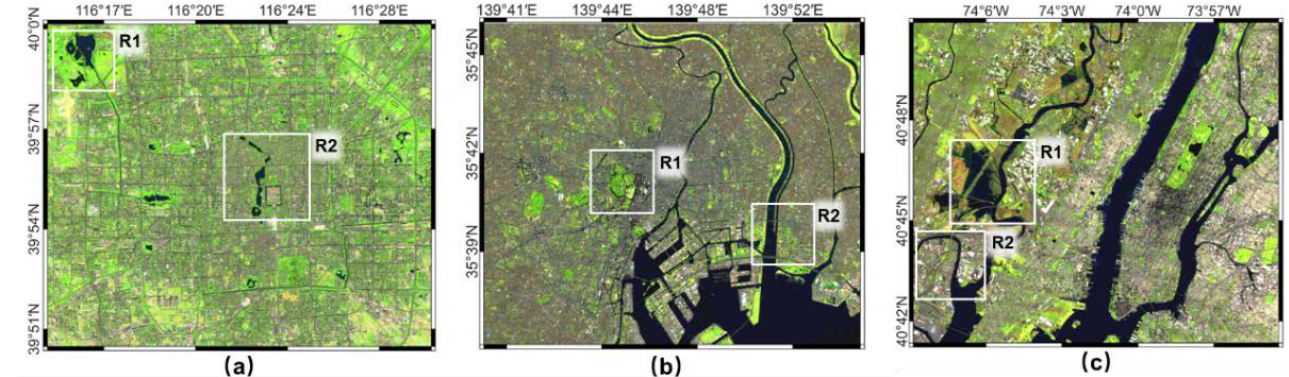
Figure 5. Selected subregions (R1 and R2) for accuracy assessment in each validation city, ( a ) Beijing, ( b ) Tokyo, and ( c ) New York. The false color image was composed using the SWIR1, NIR, and red bands.